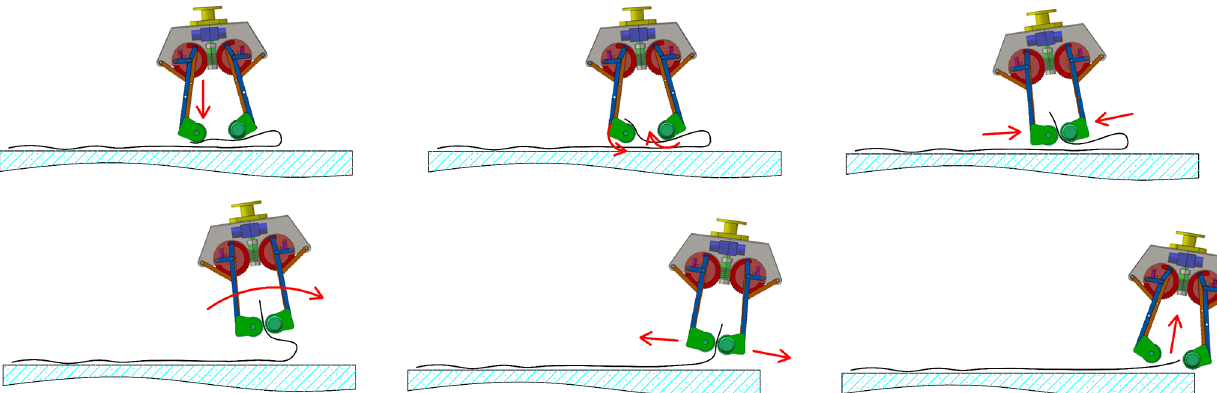
Figure 11. Diagram of the corner grabbing-and-spreading process.